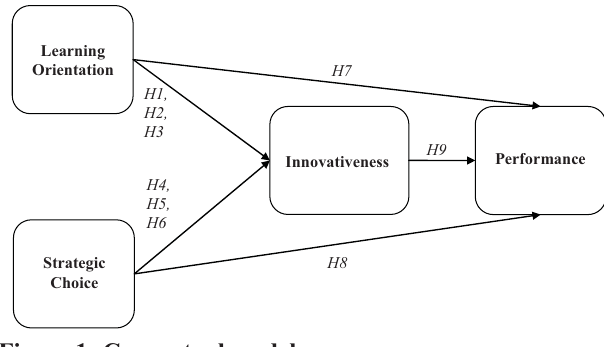
Figure 1: Conceptual